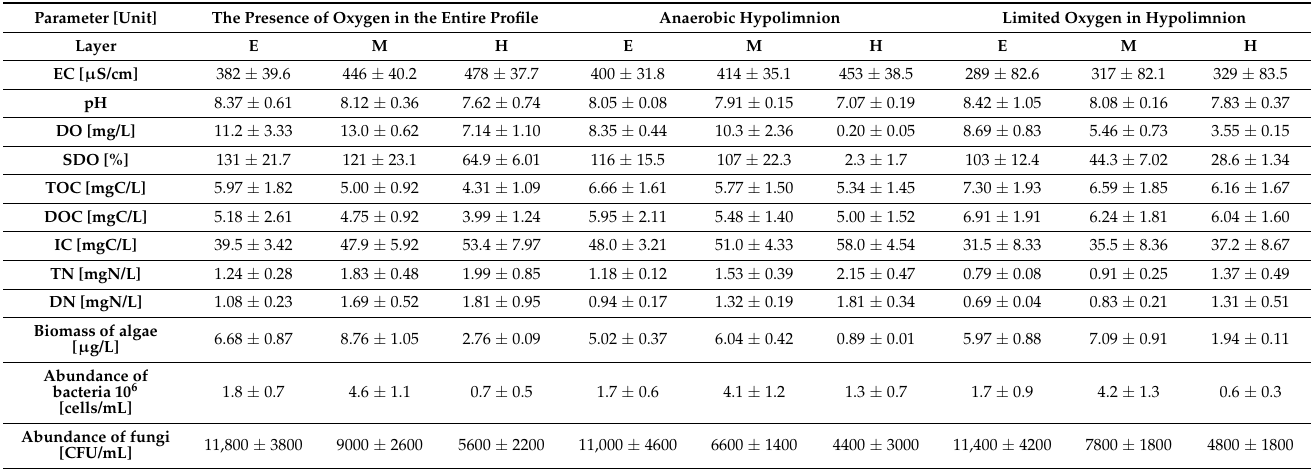
Table 3. Average values and standard deviations of selected physicochemical parameters of water quality and the abundance of bacteria and fungi for particular layers of mesotrophic